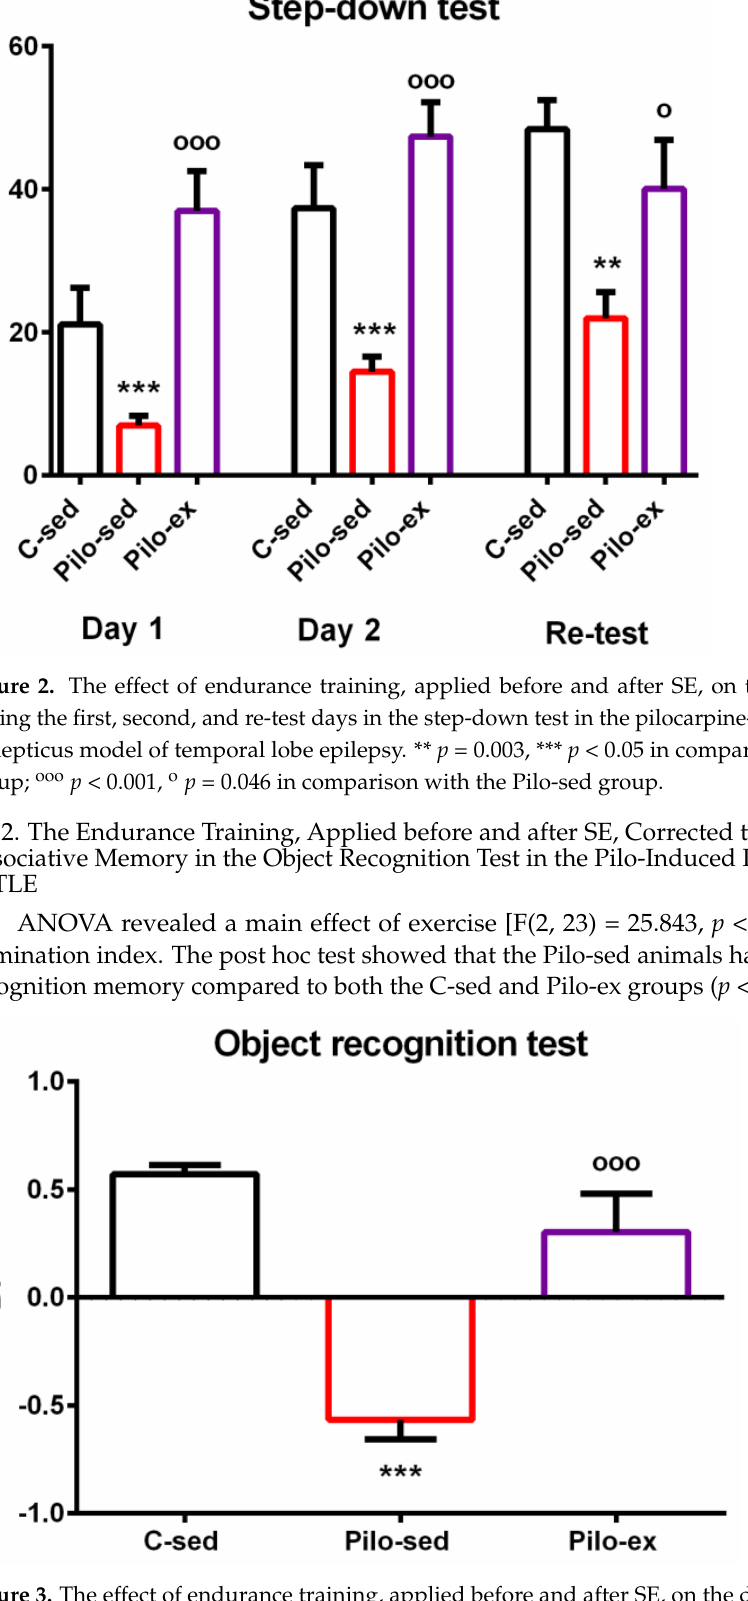
Figure 3. The effect of endurance training, applied before and after SE, on the discrimination index in the pilocarpine-induced post-SE model of TLE. *** p < 0.001 in comparison with the C-sed group; ooo p < 0.001, in comparison with the Pilo-sed group.